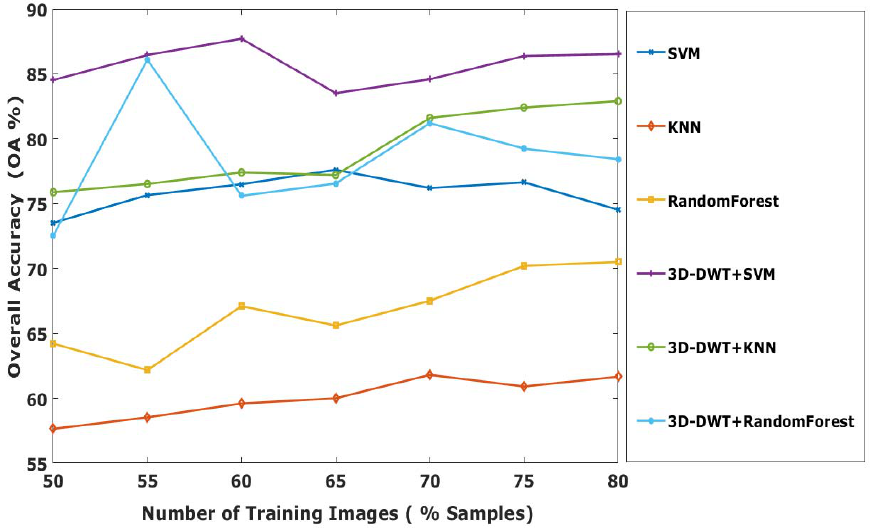
Figure 8. OA of all computing methods with different percentage of Indian Pines training samples.